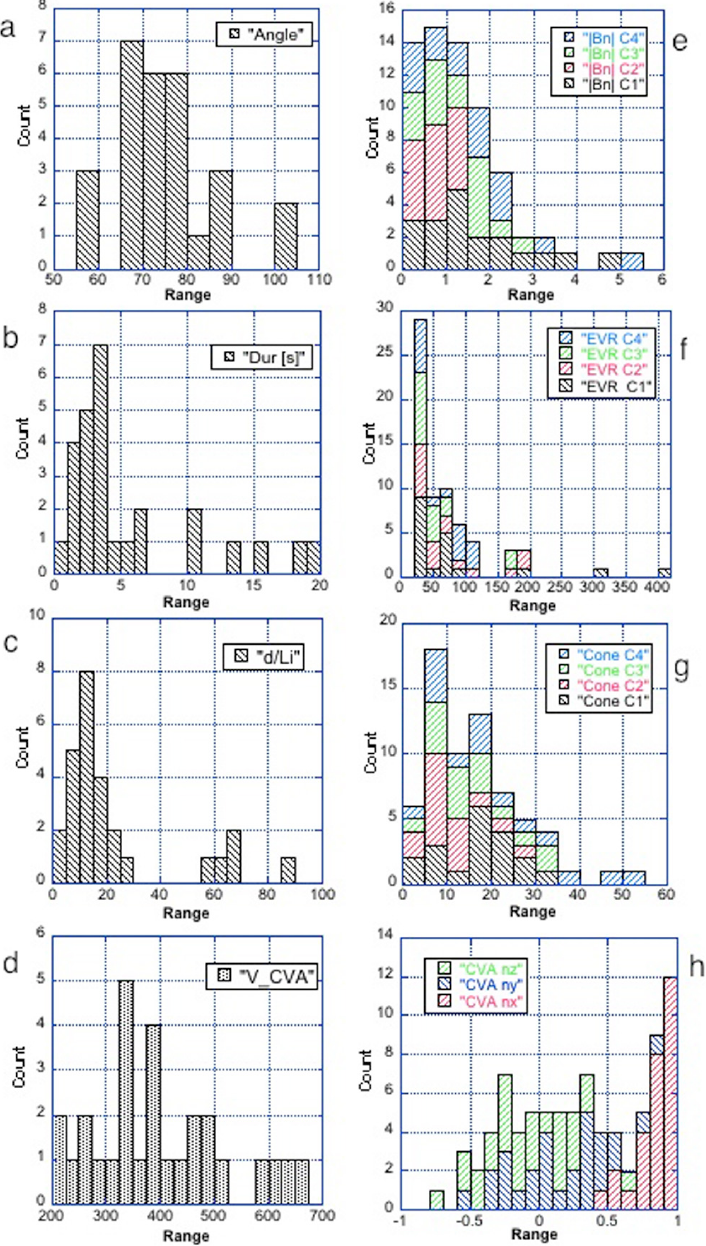
Fig. 4. Histograms of key quantities. Left, top to bottom: (a) field shear angle across DD; (b) DD-duration; (c) DD-thickness in units of the ion inertial length λ i (labeled d/Li in figure); (d) DD-speeds from triangulation. Right: (e) B n values for C1–C4 in standard Cluster color coding (black: C1, red: C2, green: C3, and blue: C4); (f) associated eigenvalue ratios; (g) cone angles between MVA and triangulation normals for C1–C4; (h) components of the triangulation normals themselves. For the B n , eigenvalue ratio, and cone angle histograms, all cases with eigenvalue ratios ≤ 20 were excluded. For Event 4 s , the duration and thickness are